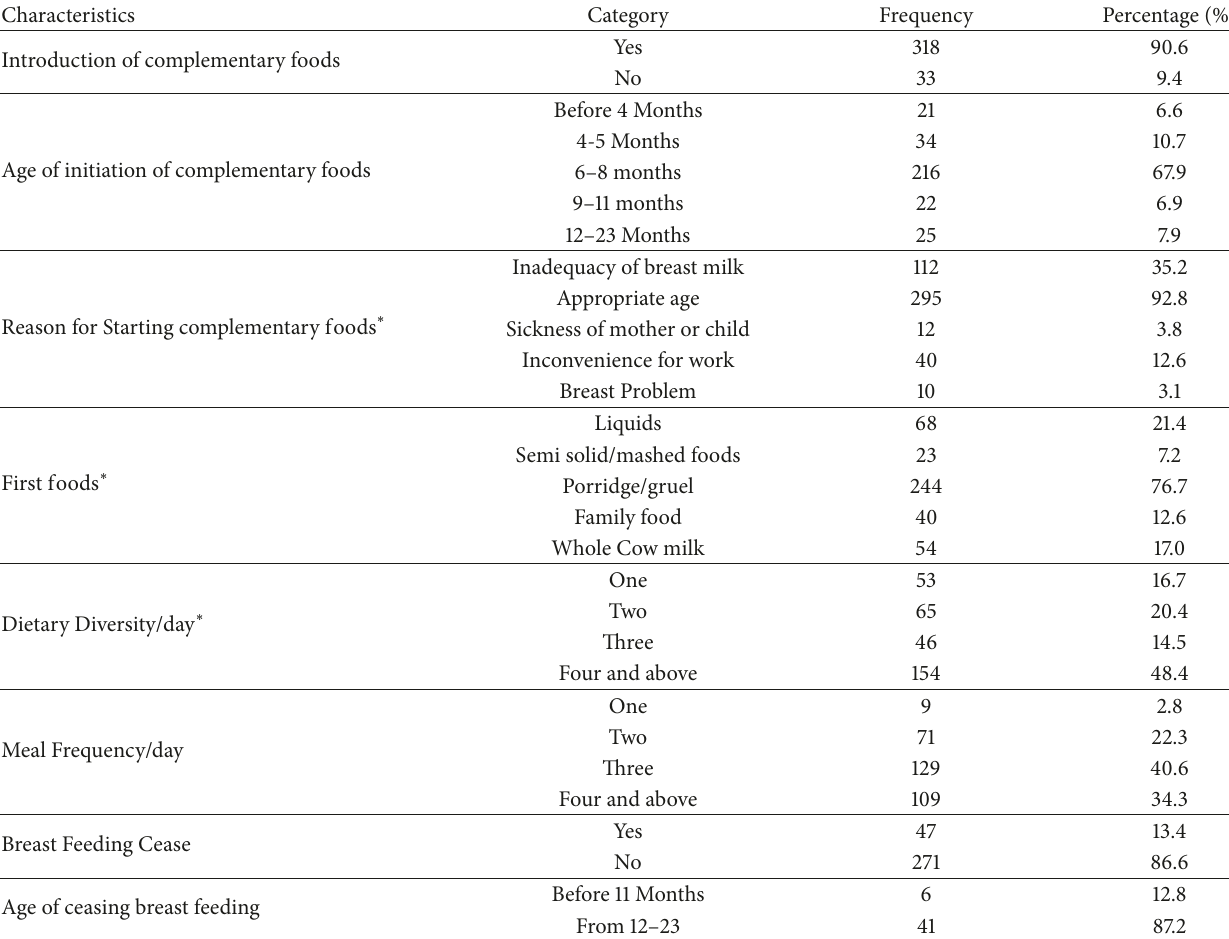
Table 3: Weaning related findings in Feres Bet Town, Amhara, Ethiopia,